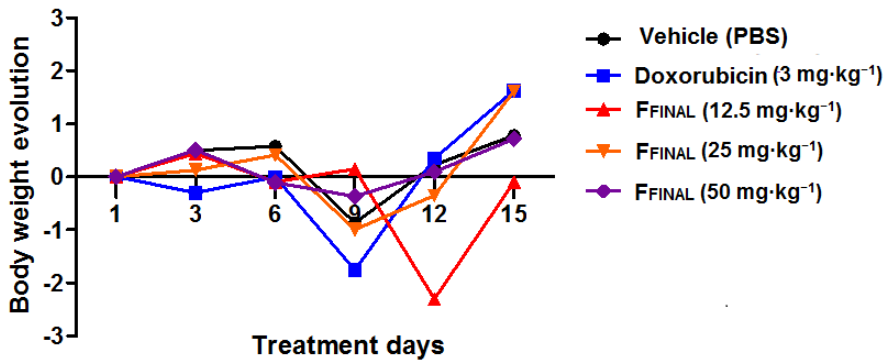
Figure 6. Animal bodyweight variation in Ehrlich solid tumor experiment - F FINAL fraction Animal bodyweight variation during 15 days of treatment; Female Balb / c mice ( n = 8 / group); Treatments (orally every day): vehicle (PBS pH 7.0 + Tween 80, 10 mL · kg − 1 ), F FINAL (12.5, 25 and 50 mg · kg − 1 );